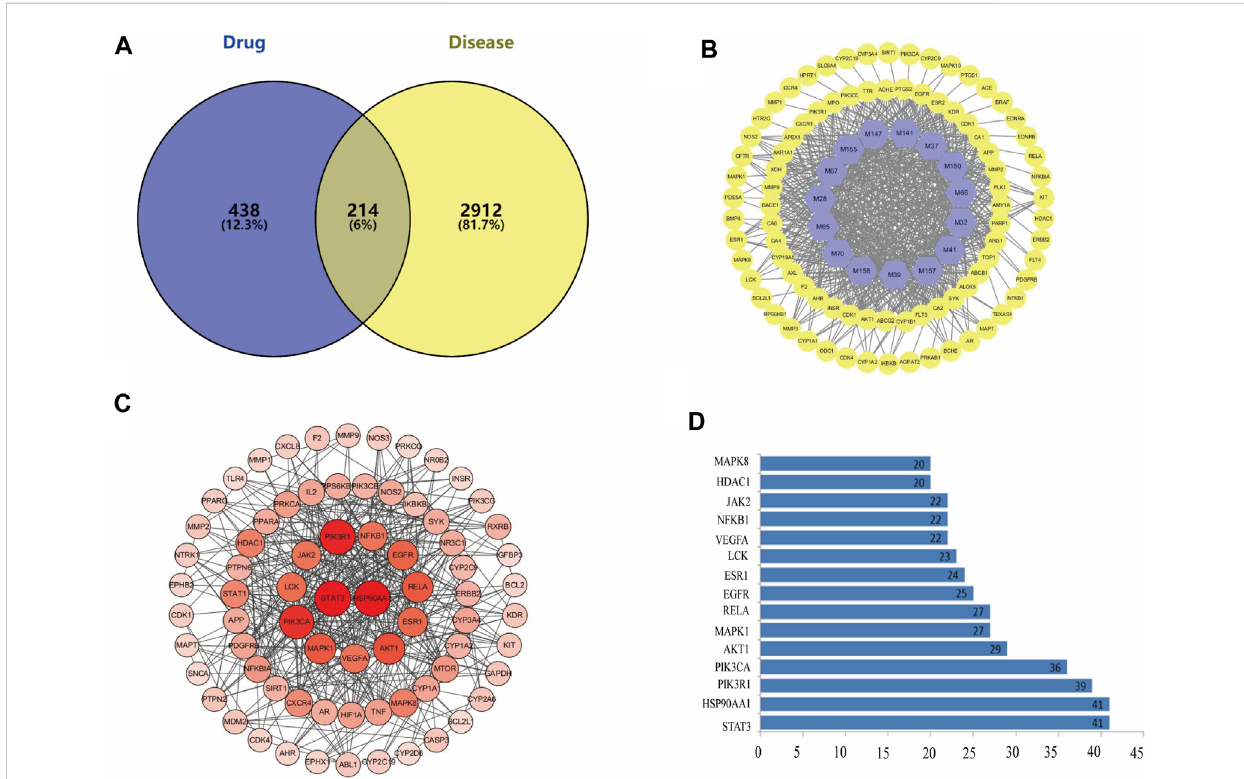
FIGURE 2 (A) There are 214 overlapping targets between disease and drug. (B) C-T network. The 86 warm yellow nodes indicate the potential active ingredients of dryness effect. The 15 light blue nodes indicate coincident targets between disease and drug. The edges denote that nodes can interact with each other. (C) Details of the PPI Network. According to the degree value of each target, the larger the degree value, the redder the color, and the larger the circle. (D) Bar plot of the PPI network. The x-axis represents the number of neighboring proteins of the target protein. The y-axis represents the target